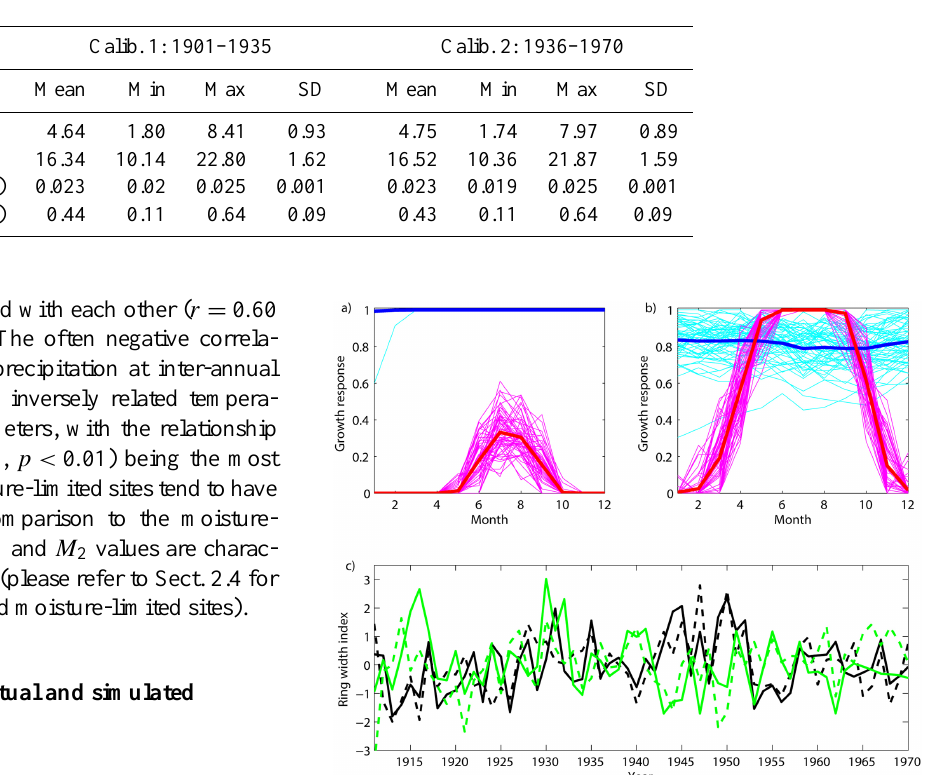
Table 2. Statistics of the Bayesian estimation of the site-by-site tuned VSL growth response parameters T 1 , T 2 , M 1 , and M 2 for the 1901– 1935 and 1936–1970 calibration intervals.